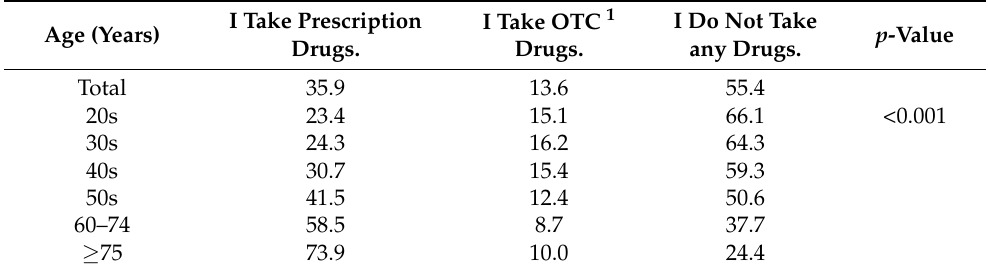
Table 3. Statement of